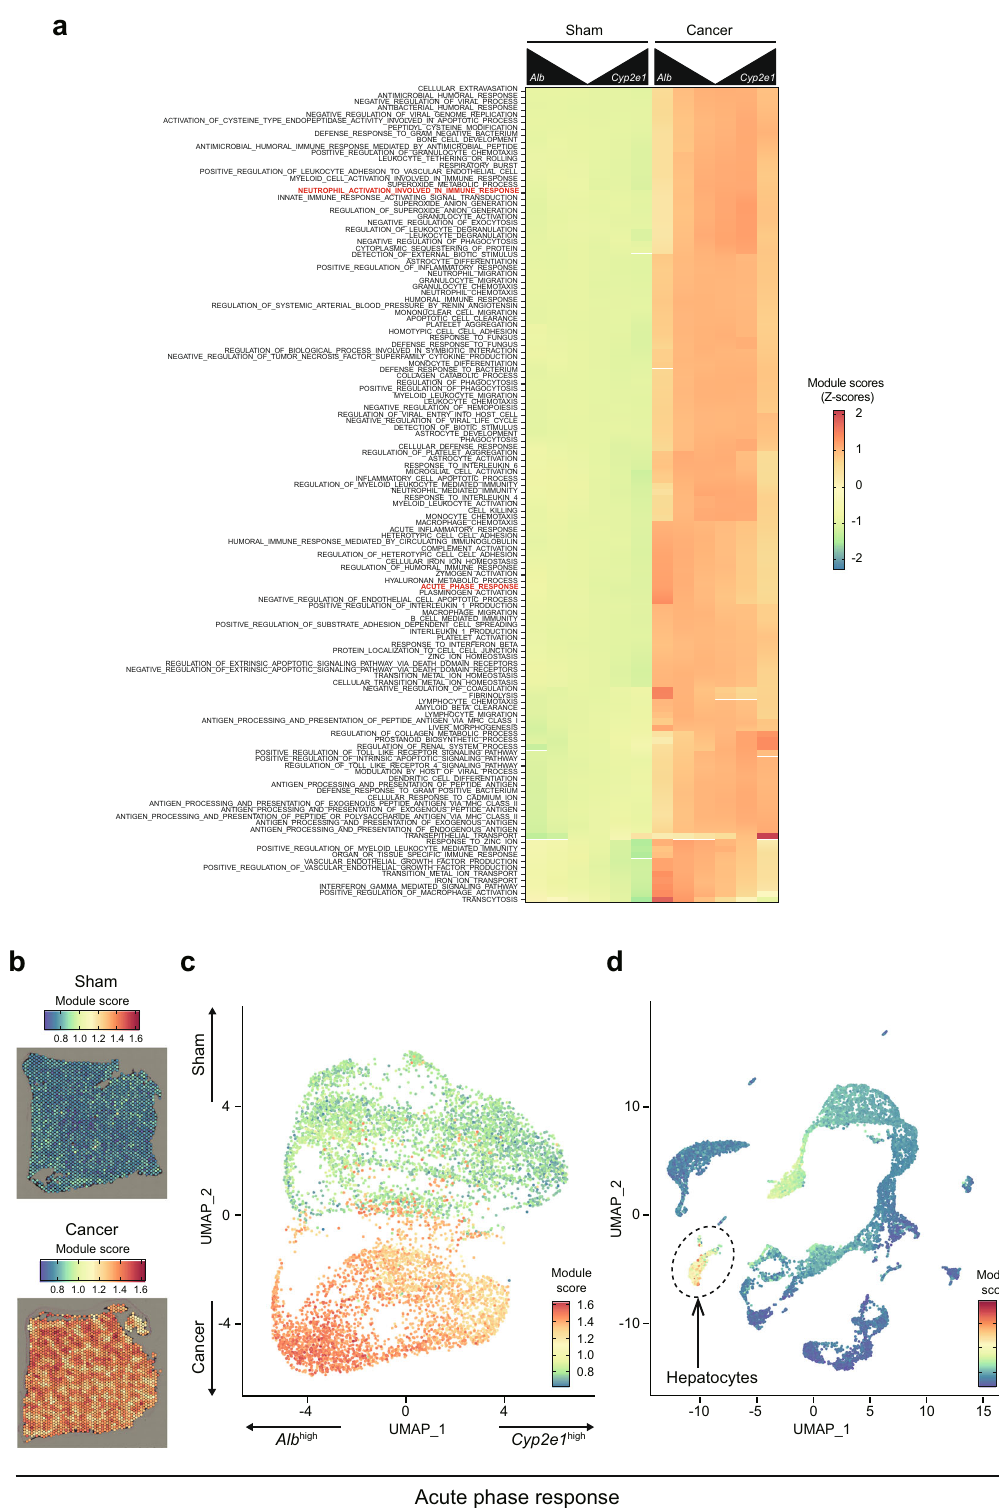
Fig. 4 4T1 breast cancers induce acute phase response in a zonated manner. a Heatmap showing the normalized module scores of selected GO terms in the function of their distance to Alb high and Cyp2e1 high spots in sham (left) and cancer-bearing (right) samples. b , c Genes involved in the acute phase response are induced in the liver of cancer-bearing mice. b Module scores in one of the sham and cancer Visium samples. c The same module scores in a UMAP representation of the Visium data. d Module scores in the scRNA-seq data, showing high scores predominantly in the hepatocyte